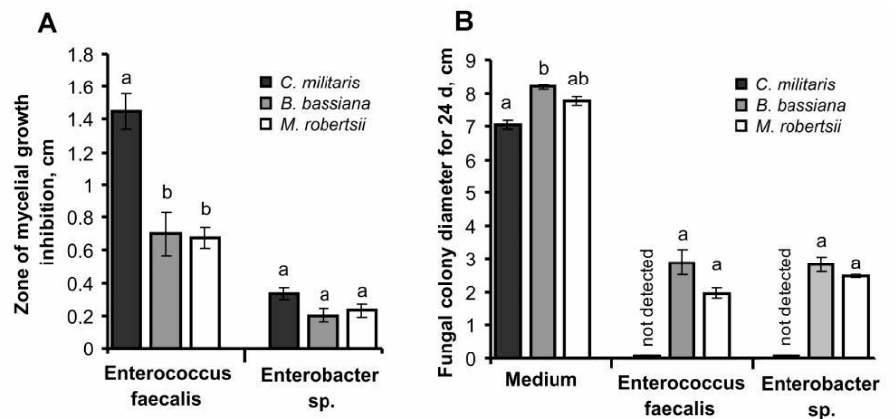
Figure 7. Inhibition of fungi by Enterococcus faecalis and Enterobacter sp . in vitro. ( A )—zone of mycelial growth inhibition by bacteria on SDAY medium. ( B )—radial growth of fungi on nutrient agar and this medium with lawns of the bacteria. Different letters indicate significant differences between treatments (Dunn’s test, p < 0.05).